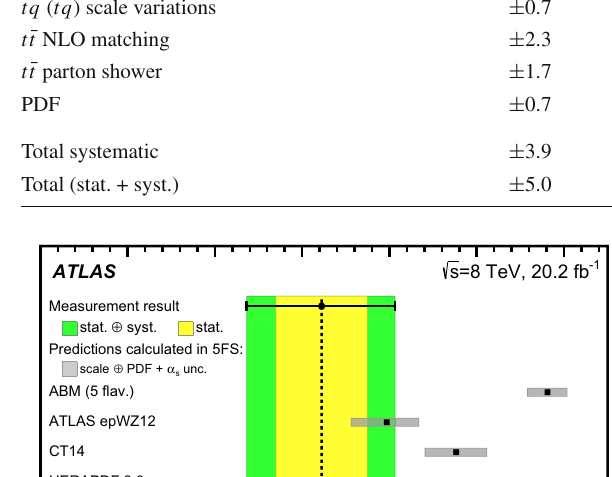
Fig. 10 Extrapolated t -channel a single-top-quark and b single-top- antiquark production cross-sections for different MC-generator setups compared to fixed-order NLO calculations. For the three calculations, the uncertainty from the renormalisation and factorisation scales are indicated in darker shading , and the total uncertainties, including the renormalisation and factorisation scale as well as the PDF + α S uncer- tainties, are indicated in lighter shading . For the NNLO prediction, only the renormalisation and factorisation scale uncertainty is provided in Ref. [22]. For comparison, the PDF + α S uncertainties from the NLO prediction[14]areaddedtotheNNLOrenormalisationandfactorisation scale uncertainty reflected in the lighter shaded uncertainty band. For this comparison, the uncertainty in the extrapolation does not include the contribution from the NLO-matching method and from the choice of parton-shower model